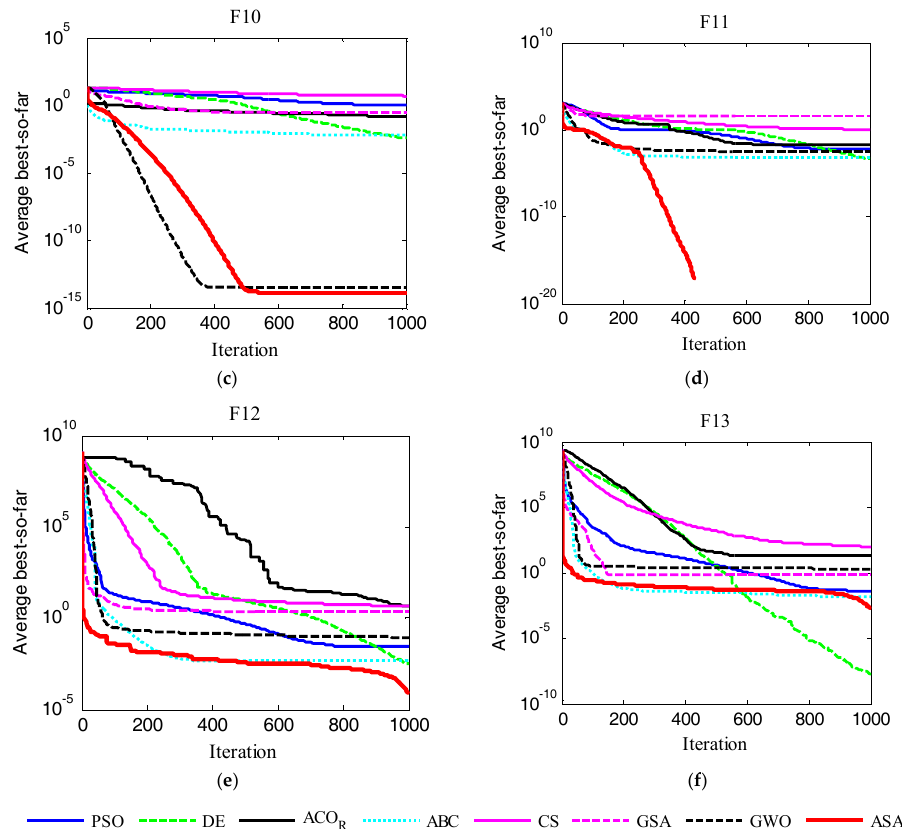
Figure 9. Comparison of performance of different algorithms for minimization of high dimensional multimodal functions. ( a ) multimodal test function F 8 ; ( b ) multimodal test function F 9 ; ( c ) multimodal test function F 10 ; ( d ) multimodal test function F 11 ; ( e ) multimodal test function F 12 and ( f ) multimodal test function F 13 .